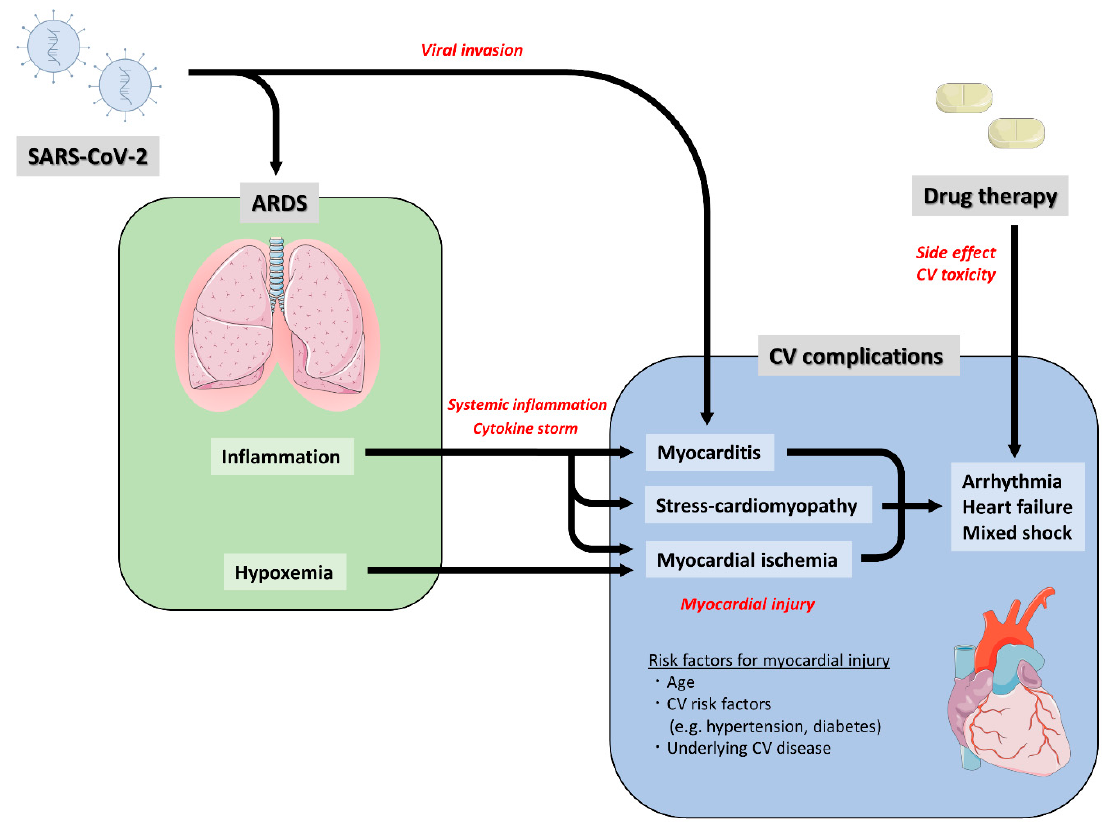
Figure 1. Potential Mechanisms of Cardiovascular Complication Caused by COVID-19. ARDS, acute respiratory distress syndrome; COVID-19, coronavirus disease 2019; CV, cardiovascular. Images were adapted from smart.servier.com by Kensuke Matsushita, 2020, https: // creativecommons.org / licenses / by / 3.0 /